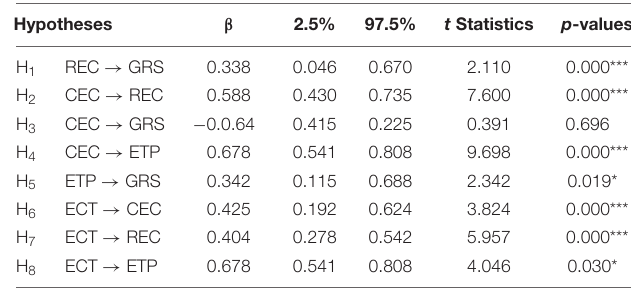
TABLE 4 | Discriminant validity. Fornell–Larcker test Heterotrait–monotrait ratio